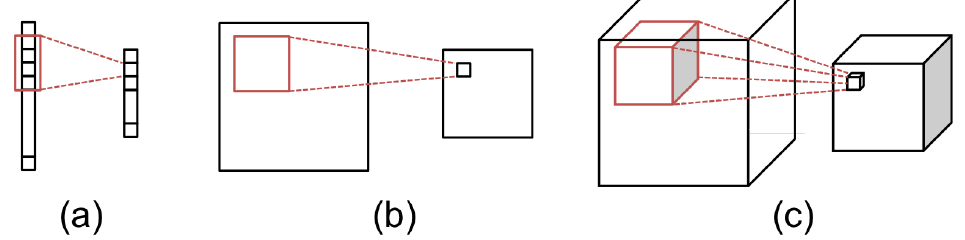
Figure 7. An illustration of different convolution operations: ( a ) 1D convolution (with 1D filter) ( b ) 2D convolution (with 2D filter) and ( c ) 3D convolution (with 3D filter). For each of the images, the left part is the input of convolution and the right is the output. The filter is shown in